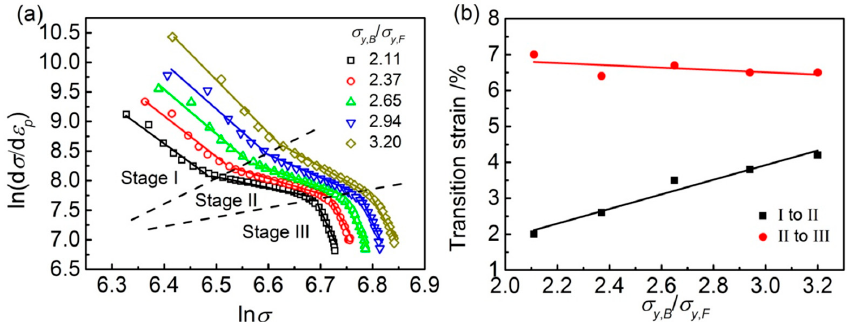
Figure 4. ( a ) Modified C-J analysis of models, and ( b ) transition strain vs. σ y , B / σ y , F of the models.